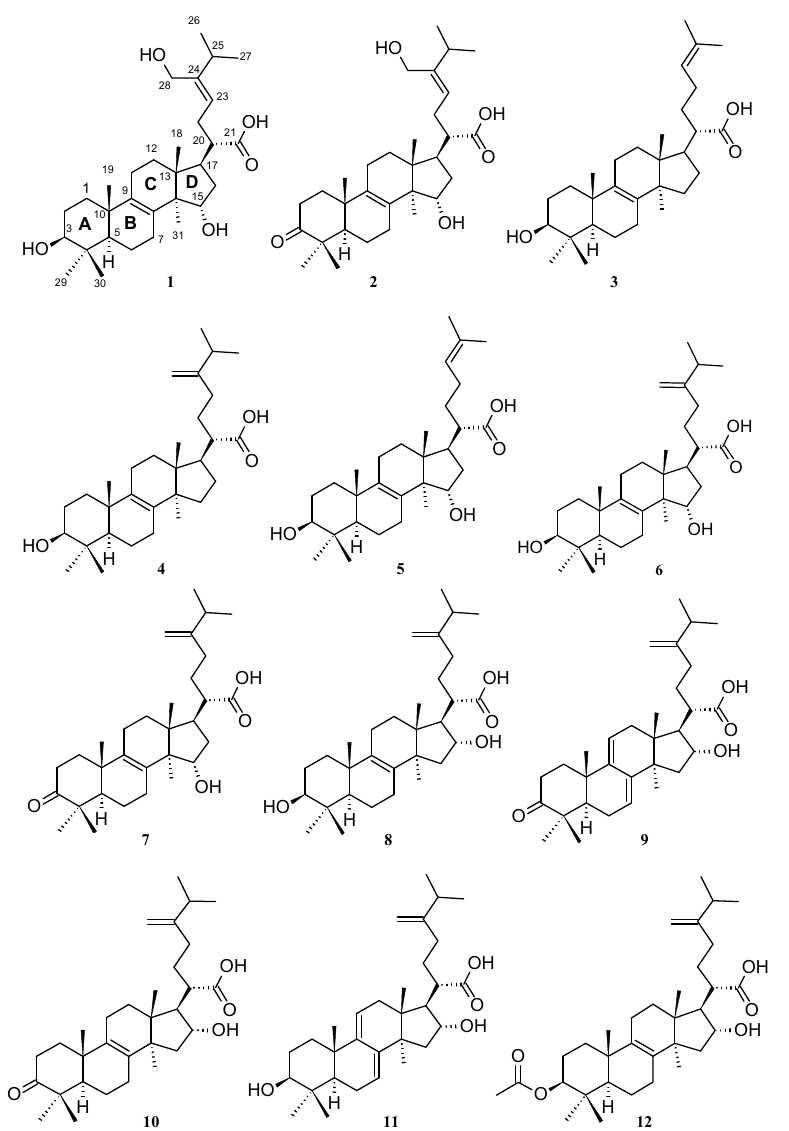
Figure 1. Isolated triterpenoids from L. sulphureus ( 1–7 ) and Antrodia sp. MUCL 56049 ( 8–12 ). The metabolites from Antrodia sp. MUCL 56049 included tumulosic acid or (3 β ,16 α )- dihydroxy-24-methylenelanost-8-en-21-oic acid ( 8 ) [18], polyporenic acid C or 16 α -hydroxy- 24-methylene-3-oxolanosta-7,9(11)-dien-21-oic acid ( 9 ) [19], 16 α -hydroxyeburiconic acid or 16 α -hydroxy-24-methylene-3-oxolanost-8-en-21-oic acid ( 10 ) [19], dehydrotumulosic acid or (3 β ,16 α )-dihydroxy-24-methylene-lanosta-7,9(11)-dien-21-oic acid ( 11 ) [20], and pachymic acid or 3 β -acetyloxy-16 α -hydroxy-24-methylene-lanost-8-en-21-oic acid ( 12 ) [21]. Interestingly, according to the literature, including our own previous results [12], none of these triterpenoids has been shown to exhibit any significant cytotoxic effects.